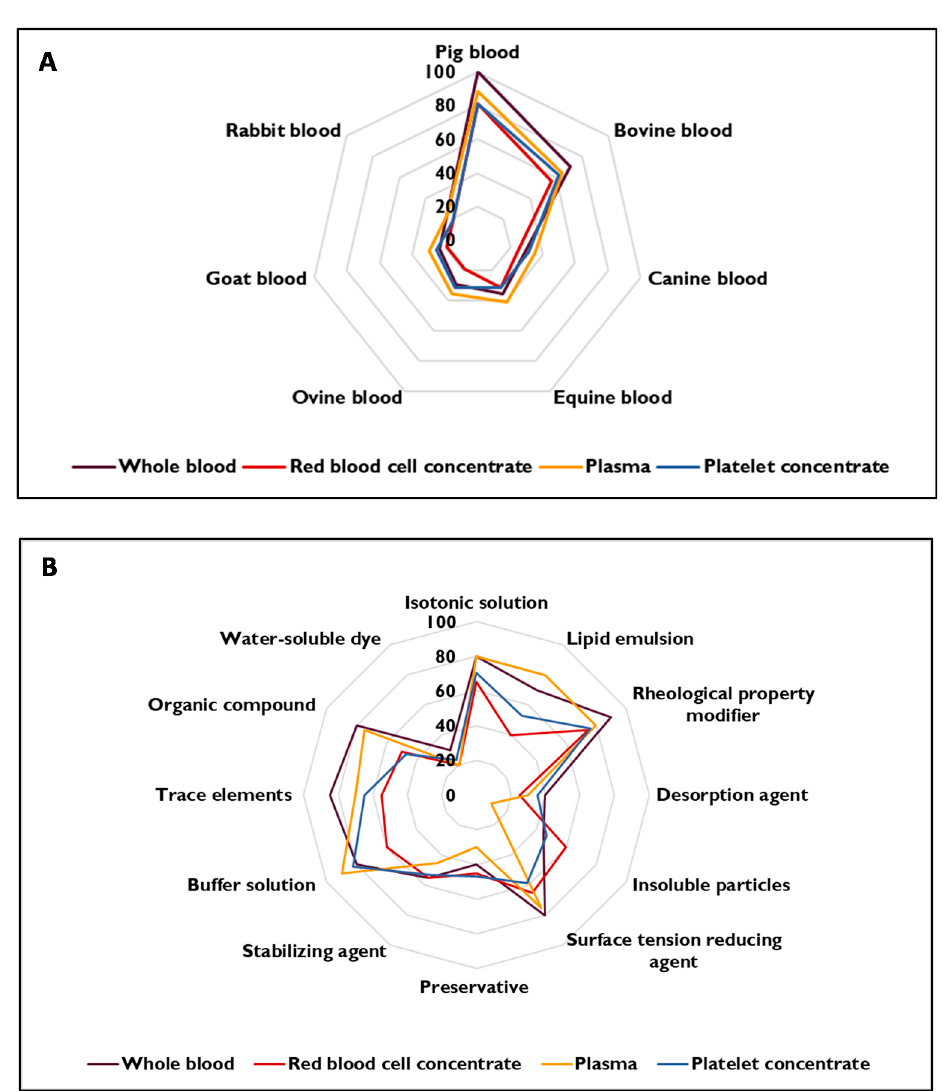
Figure 4. Relevance scores for each natural technical solution ( A ) or synthetic technical solution ( B ) for each labile blood product.